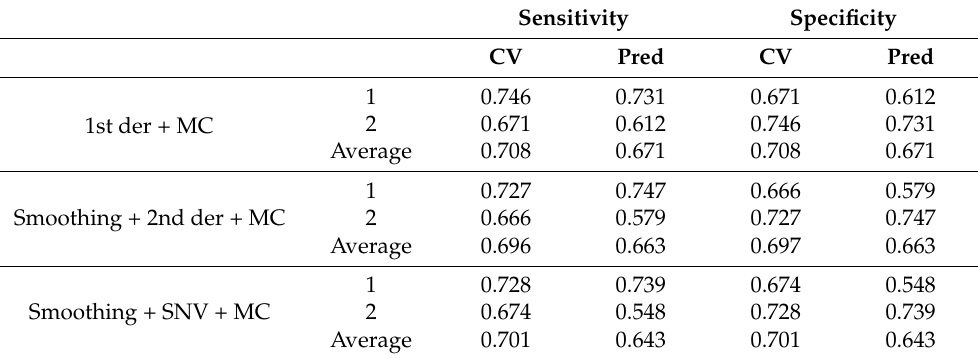
Table 4. Sensitivity and specificity values for the 3 classification